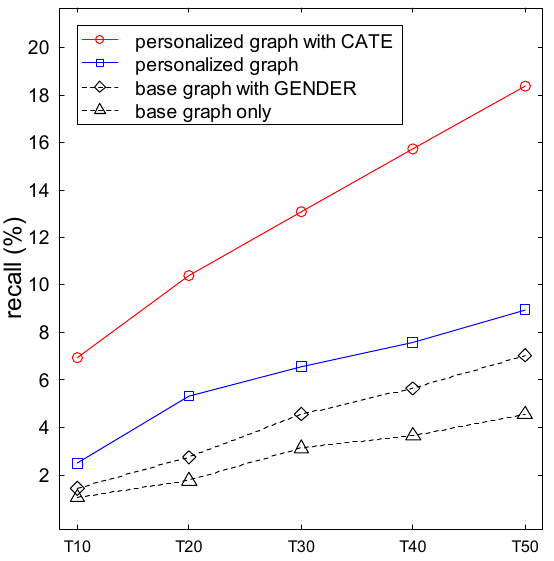
Figure 8. E ff ect of each of components in proposed Figure 8. Effect of each of components in proposed method.